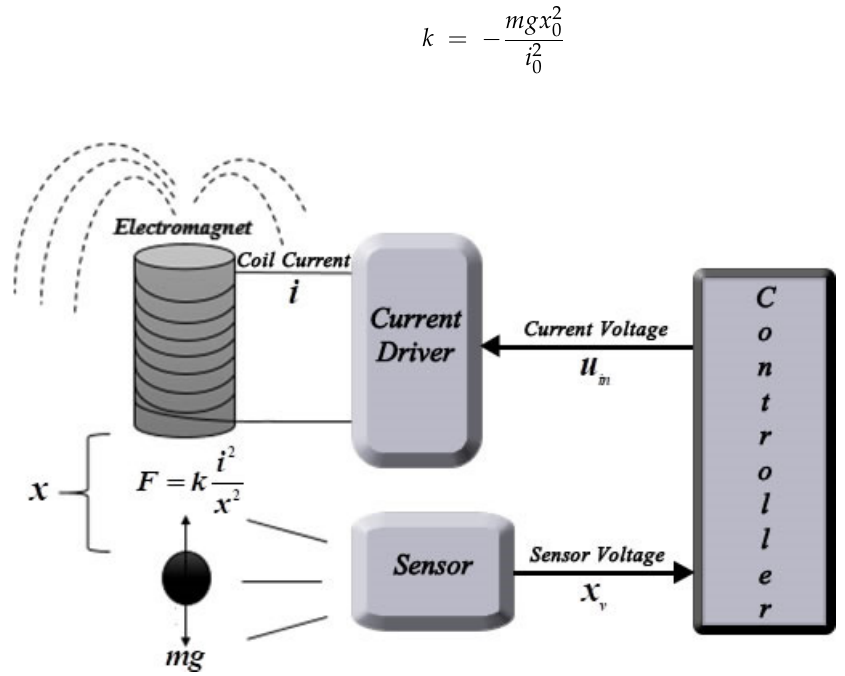
Figure 1. Block diagram of the Maglev System.